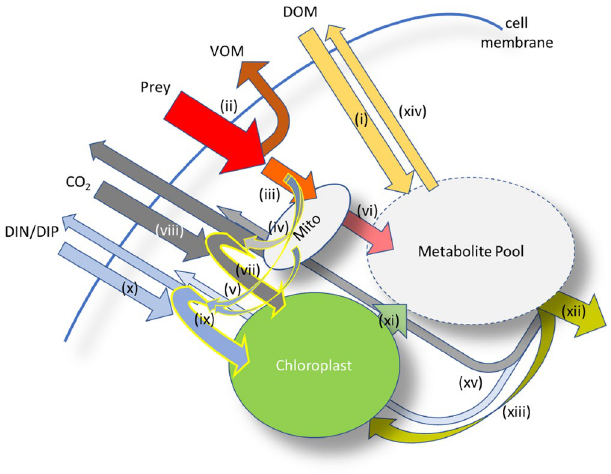
Figure 1. Schematic showing the coupling of physiological processes within a mixoplankton cell, supporting the synergism between phototrophy and phagotrophy. (i) Dissolved Organic Matter (DOM; sugars, amino acids etc.) is taken up and enters the metabolite pool; this action supports osmotrophy. (ii) Prey are engulfed, and a fraction (ca. 20–40%) egested as voided organic matter (VOM) during digestion. (iii) The retained fraction is broken down and a further fraction (ca. 30%) is lost through specific dynamic action (SDA) as (iv) CO 2 and as (v) dissolved inorganics (DIN, nitrogen as ammonium; DIP, phosphorus as phosphate). This activity (iii-v) is associated with the mitochondria (Mito) and other sub-cellular compartments. (vi) The resultant remaining material enters the metabolite pool. (vii) The CO 2 lost through SDA contributes to satisfying CO 2 demands for photosynthesis in chloroplasts (yellow edged arrow). (viii) Any additional CO 2 demand is brought in from outside of the cell. (ix) DIN/DIP lost through SDA contribute to DIN & DIP demands for phototrophy (yellow edged arrows). (x) Any additional demand for DIN and/or DIP over that supplied by recycling is brought in from outside. (xi) Products from phototrophy contribute to the metabolite pool. The total metabolite pool supports (xii) biomass growth including (xiii) synthesis of chloroplasts. (xiv) Excess metabolites are leaked out of the cell. (xv) Additional losses include loss of CO 2 through respiration, with allied regeneration of DIN (as ammonium) and DIP (as phosphate) to maintain cellular stoichiometric balance. The metabolite pool equates to M C in the model, as shown in Fig.